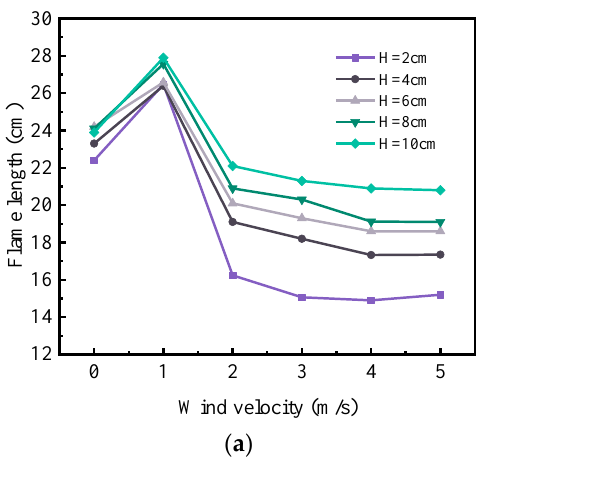
Figure 9. ( a ) Flame length of the pool fires in the experiments. ( b ) Flame height of the pool fires in the experiments and Chen’s study [13] of flame height.